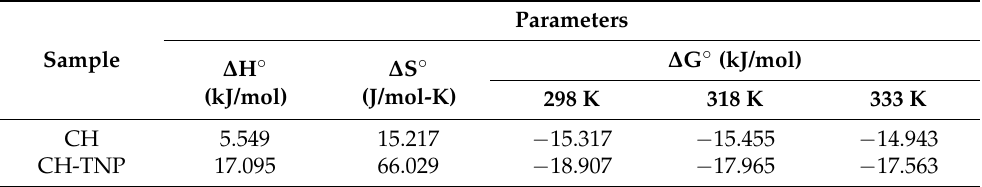
Table 5. Thermodynamic parameters for Cu(II)